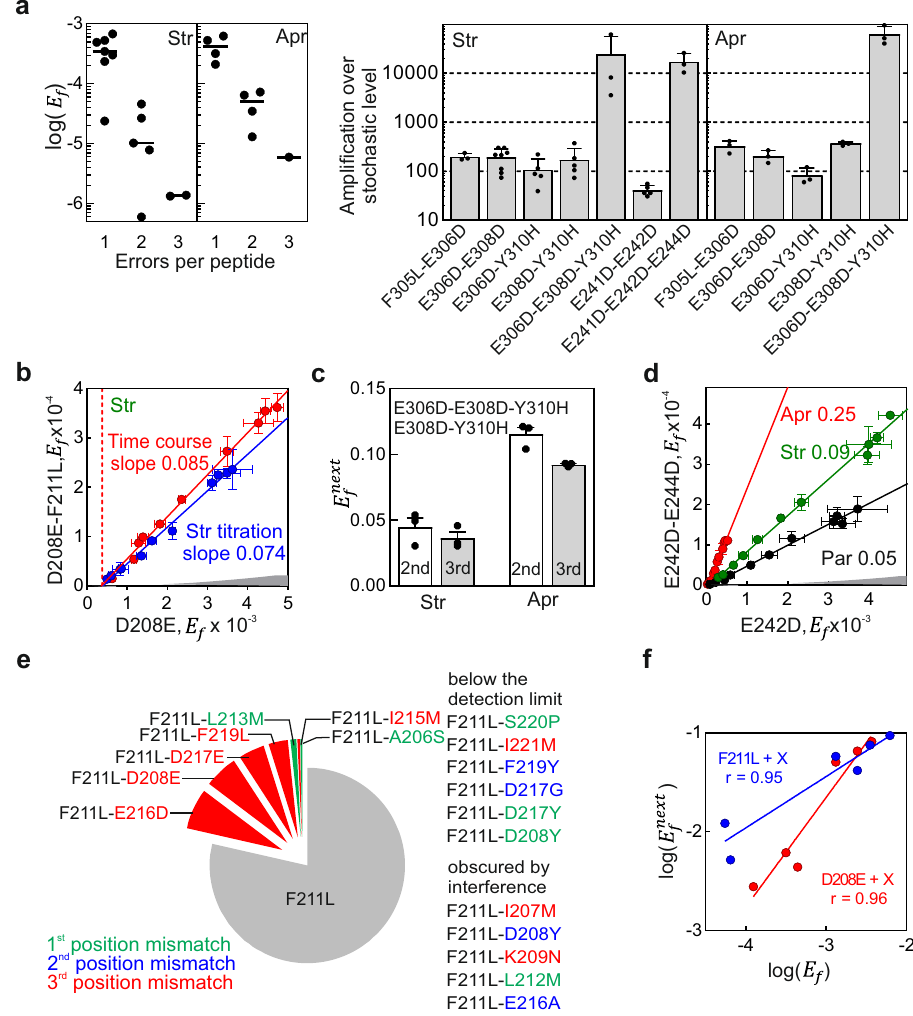
Fig. 4 Frequencies of consecutive errors. a Absolute quanti fi cation of error clusters by QRAS. Left panels: E f of one, two, or three amino acid substitutions after AGA treatment. Dash is a median value shown as a visual guide. Right panels: Error ampli fi cation is calculated as the expected stochastic occurrence of error cluster. Shown are means ± SD of at least three independent biological replicates ( n = 3). b Correlation between E 1st f and E cluster f . Peptides were quanti fi ed by PRM and LFQ assuming identical ionization and fragmentation properties. Shown are means ± SD of three technical replicates ( n = 3). c E next f for the 2 nd and 3 rd errors in the cluster. E next f is calculated as SD of three independent biological replicates ( n = 3). d Example of E next f for the E242D – E244D cluster induced by different AGAs. Gray shaded area represents the expected stochastic error cluster frequency for the two positions. Shown are means ± SD of three technical replicates ( n = 3). e Misreading preferences in error clusters. Str-induced error clusters were quanti fi ed relative to their parental peptide with a single substitution (F211L) by PRM and LFQ. f Correlation in occurrence of an error as a single substitution ( E f ) or within an error cluster ð E next f Þ . Data for the probability of single errors is derived from Supplementary Fig. 1g; the probability to occur in error cluster is based on Fig. 4e and Supplementary Fig. 6. Pearson correlation coef fi cients as insets. See also Supplementary Fig. 6 and Source data fi